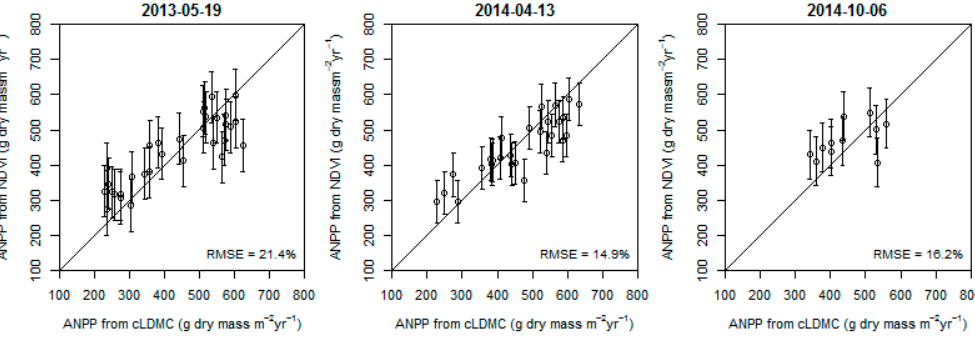
Figure 8. Scatter plots showing the validation of the three models summarised in Table 5 Solid line shows the 1:1 line and error bars represent ± root-mean-square error.